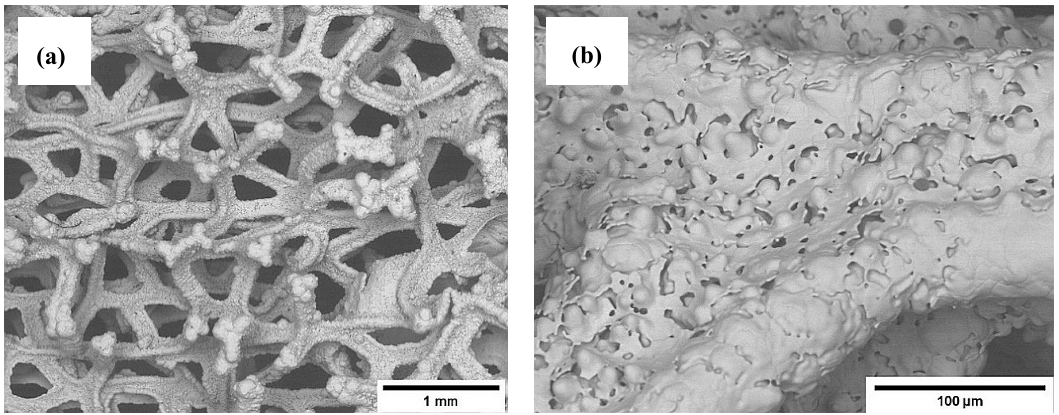
Figure 1. SEM images at low ( a ) and high ( b ) magnification of 3D copper foam.